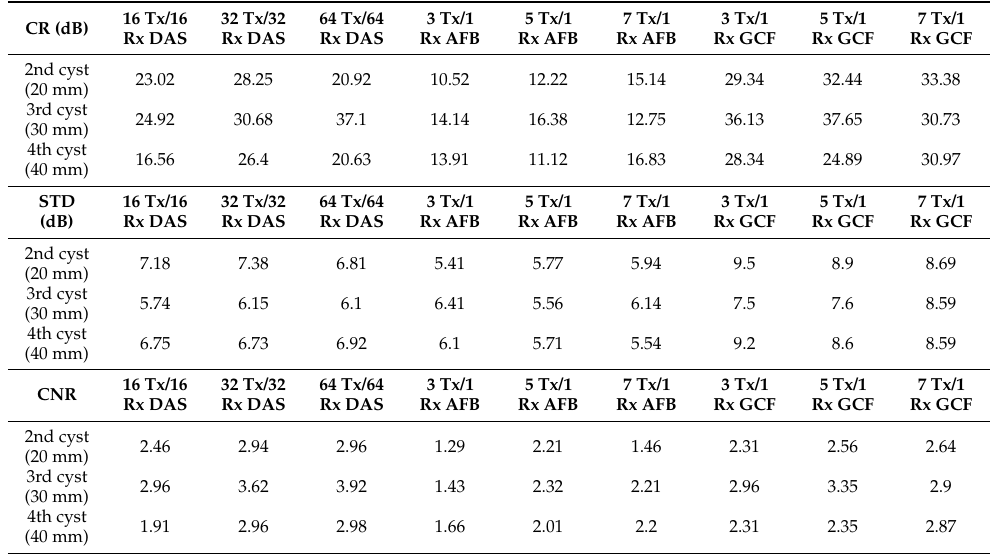
Table 2. Contrast (CR), standard deviation (STD), and contrast-to-noise ratio (CNR) of the 2nd, 3rd, and the 4th cyst images acquired with nine methods, as shown in Figure 6.